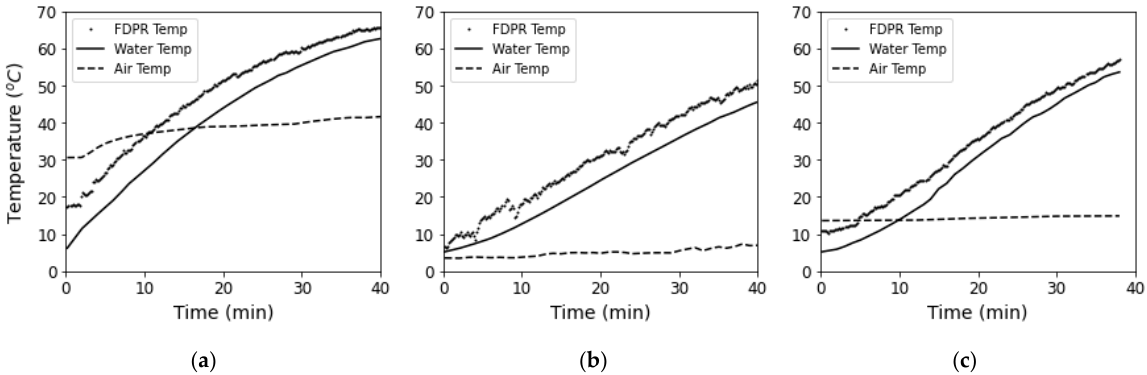
Figure 2. FDPR and thermistor measured water bath temperature at different ambient air temperatures: ( a ) high ambient air temperature; ( b ) low ambient air temperature; ( c ) mid ambient air temperature (room temperature).